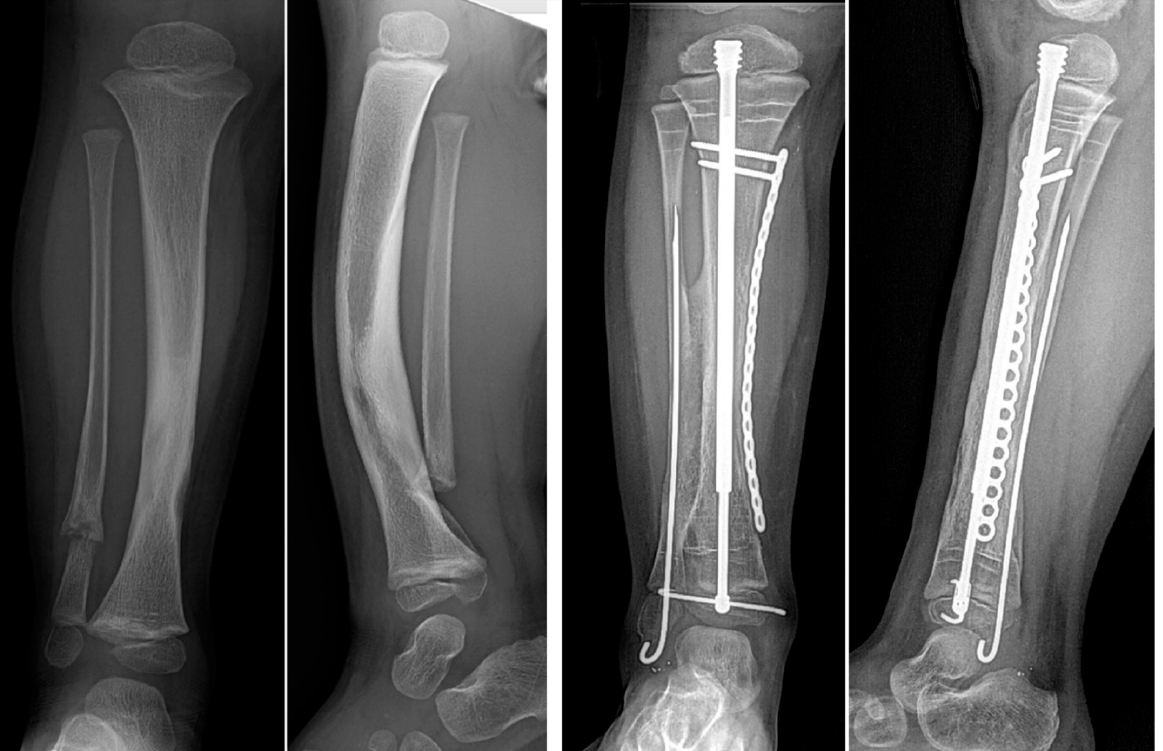
Figure 9. AP and lateral radiographs of a patient with Paley type 2A CPT. The preoperative images on the left show an intact tibia with fibular pseudarthrosis. A tibial osteotomy was made at the apex of the deformity, straightened, and fixed with the standard cross-union protocol. The postoperative images on the right show a well-healed osteotomy and cross-union with normal tibial alignment.